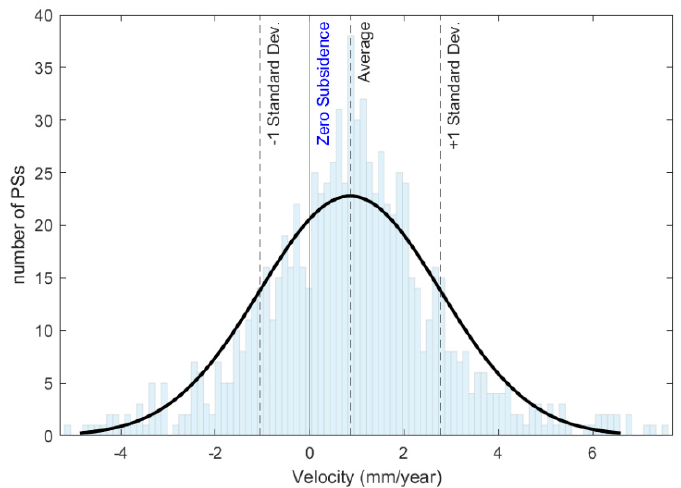
Figure 13. Distribution of velocity of the PSs in the Vian. Black line is the probability density function (PDF) of